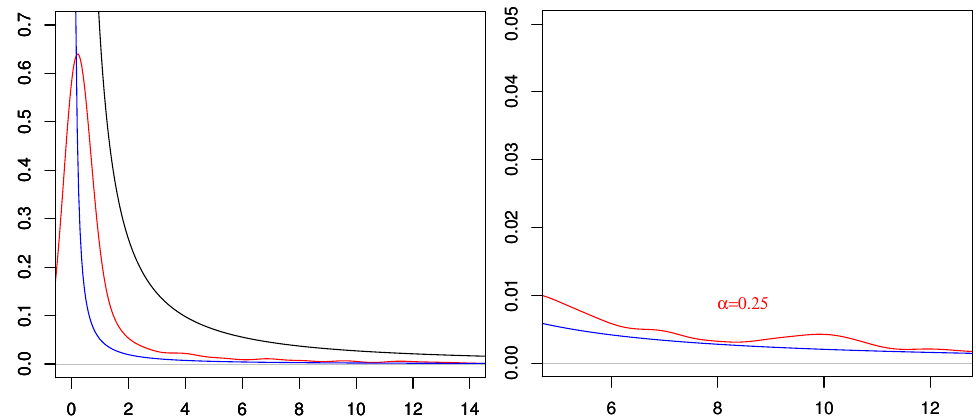
Figure 5. Case α = 0.25. Simulation details as in Figure 1. On the left , the red curve is simulated. The black curve is the plot of a ( t ) = S 1/6 · t − ( 3 + 2 α ) / ( 2 α + 2 ) with S = 0.1. The blue curve is then obtained as b ( t ) = c α · a ( t ) , with estimated value of c α = 0.075. On the right , a zoom of the simulated density (red) and the approximation curve (blue), corresponding to those on the